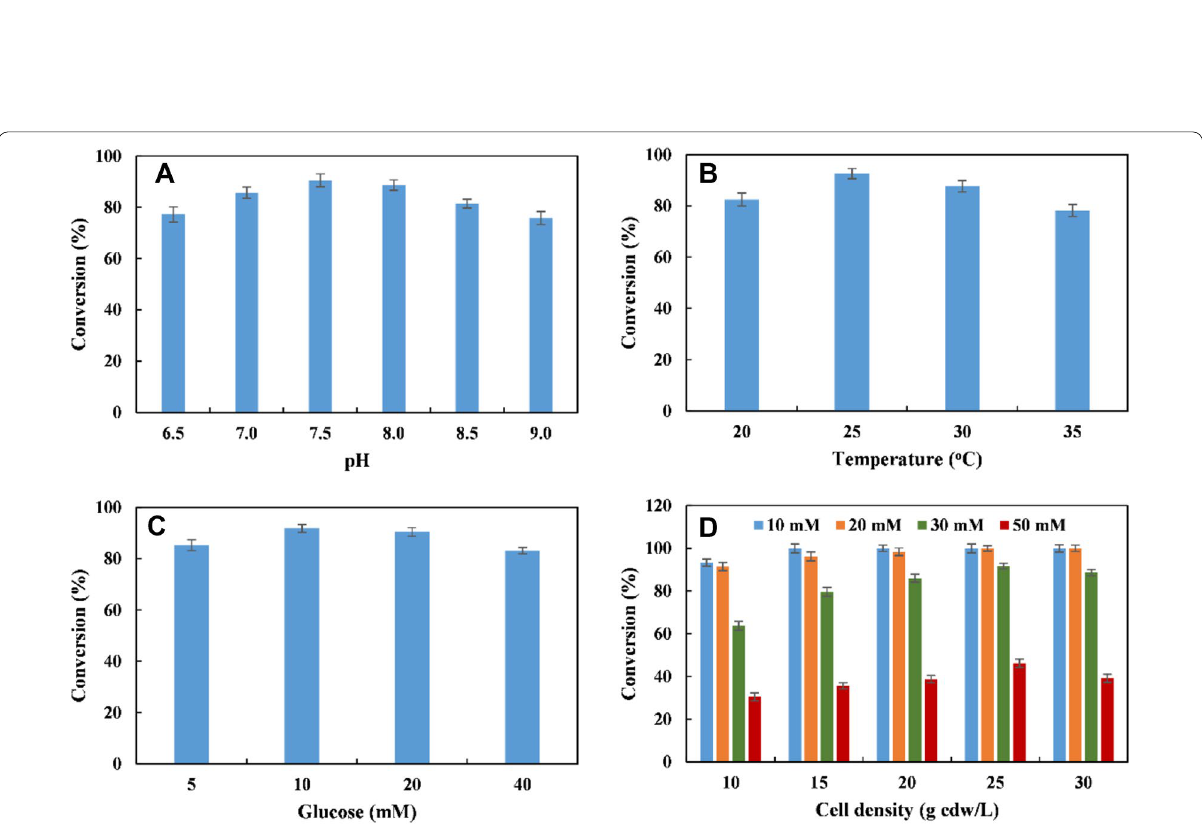
Fig. 2 Reaction condition optimization for conversion of L-PA 1 to 2-HAP 6. A Effect of different pH on the conversion of 2-HAP 6 ; B effect of different temperature on the conversion of 2-HAP 6 ; C effect of glucose concentration on the conversion of 2-HAP 6 ; D effect of different cell density of E. coli (RFP-DEA-CGS) on the conversion of different concentration of L-PA 6 , blue: 10 mM of L-PA; yellow: 20 mM of L-PA; green: 30 mM of L-PA; red: 50 mM of